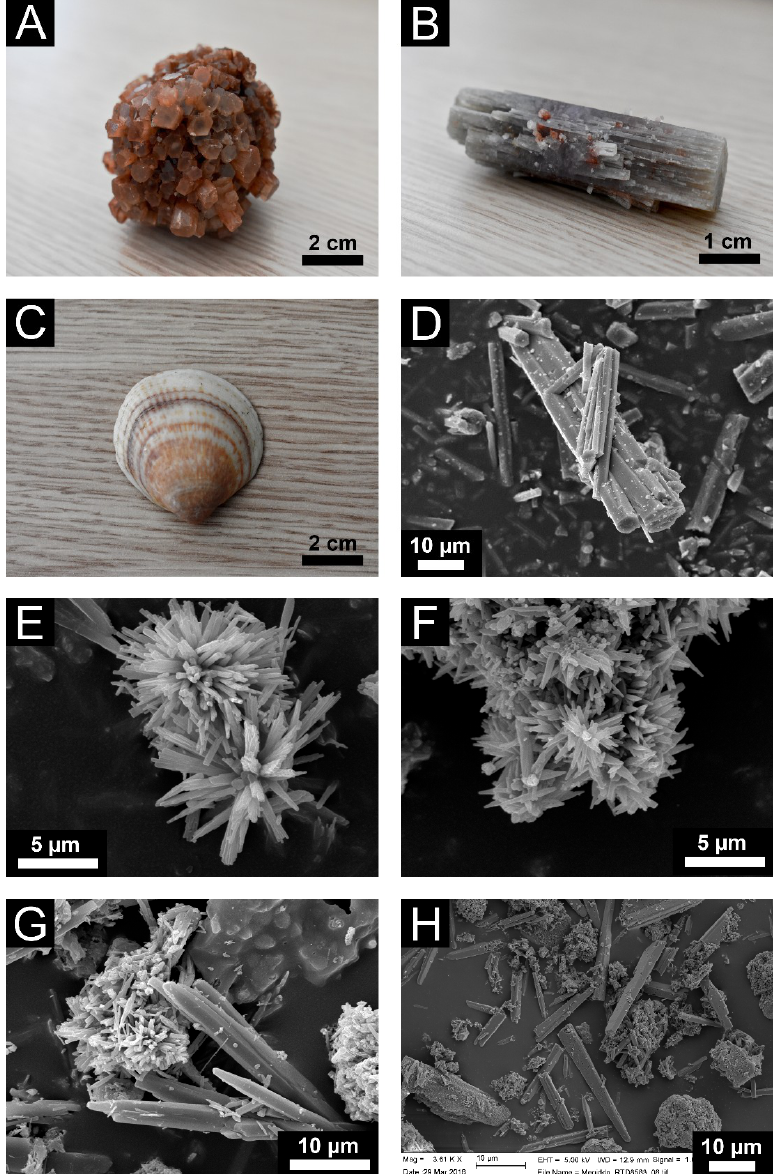
Figure 2. Materials analyzed in this study. ( A ) aragonite spar from Tazouta, Morocco. ( B ) Aragonite spar from Molina de Aragón, Spain. ( C ) Glycymeris sp. shell from Ashkelon, Israel. ( D ) SEM image of aragonite rods precipitated out of boiling water in a kettle. ( E ) SEM image of a cluster of aragonite needles precipitated out of lacustrine water in the Lake Lisan Formation at the Dead Sea, Israel. ( F ) SEM image of aragonite needles formed upon the carbonation of CaO and Ca(OH) 2 in an experimental quicklime. ( G ) SEM image of pyrogenic aragonite needles formed in high-temperature archaeological ash at Tell es-Safi/Gath, Israel. ( H ) SEM image of pyrogenic aragonite needles formed in high-temperature archaeological ash at Megiddo, Israel.